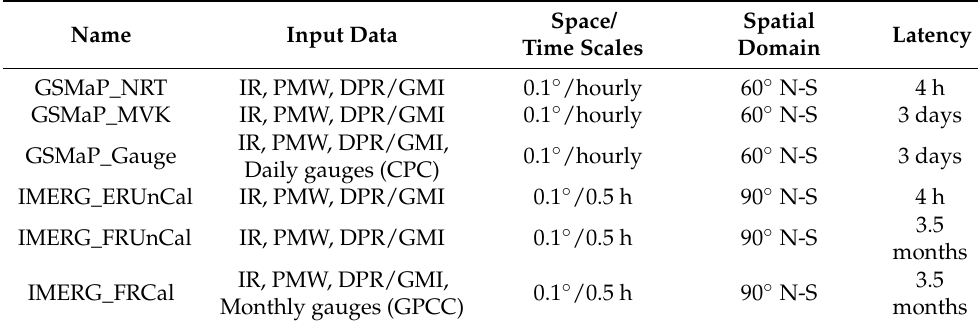
Table 1. Summary of the GSMaP and IMERG